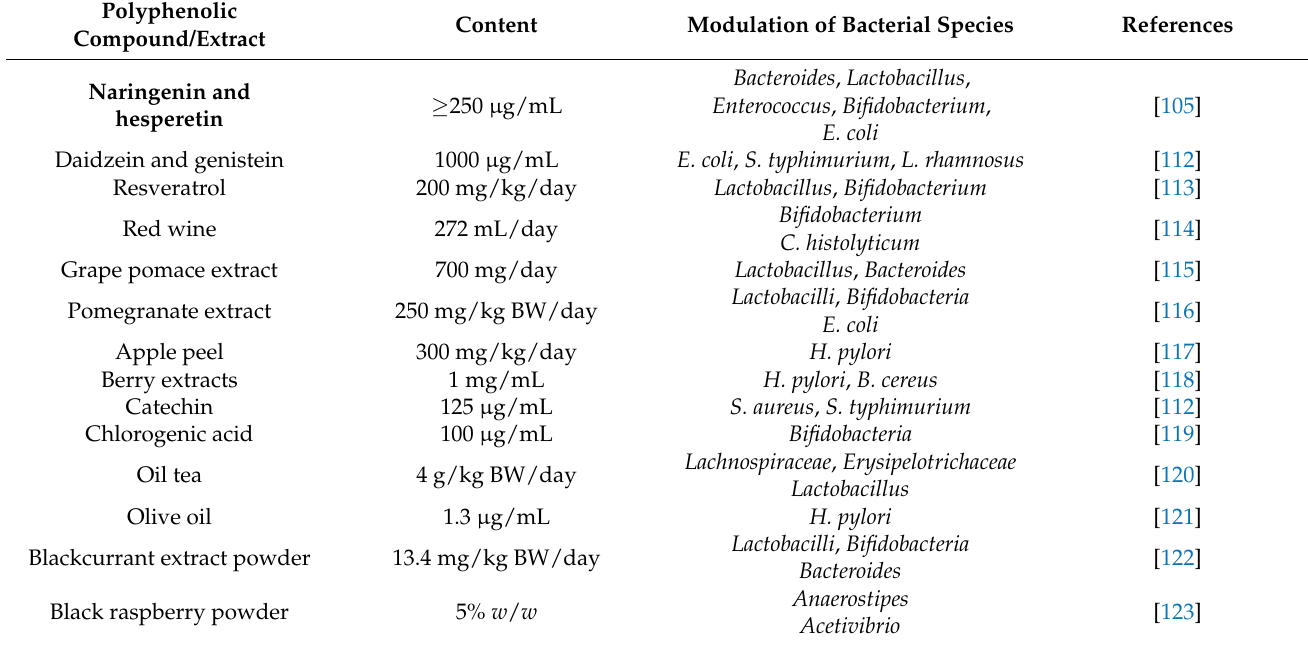
Table 2. Effect of dietary polyphenol on the growth of different bacterial